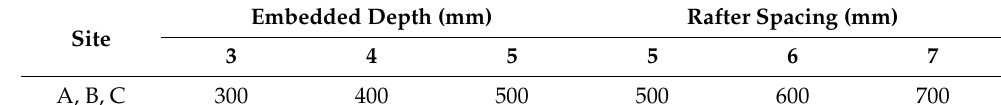
Table 2. Foundation types of single-span greenhouse [23].